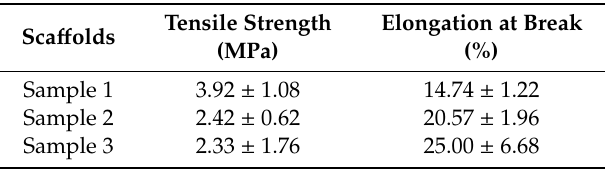
Table 3. Tensile test measurements of produced sca ff